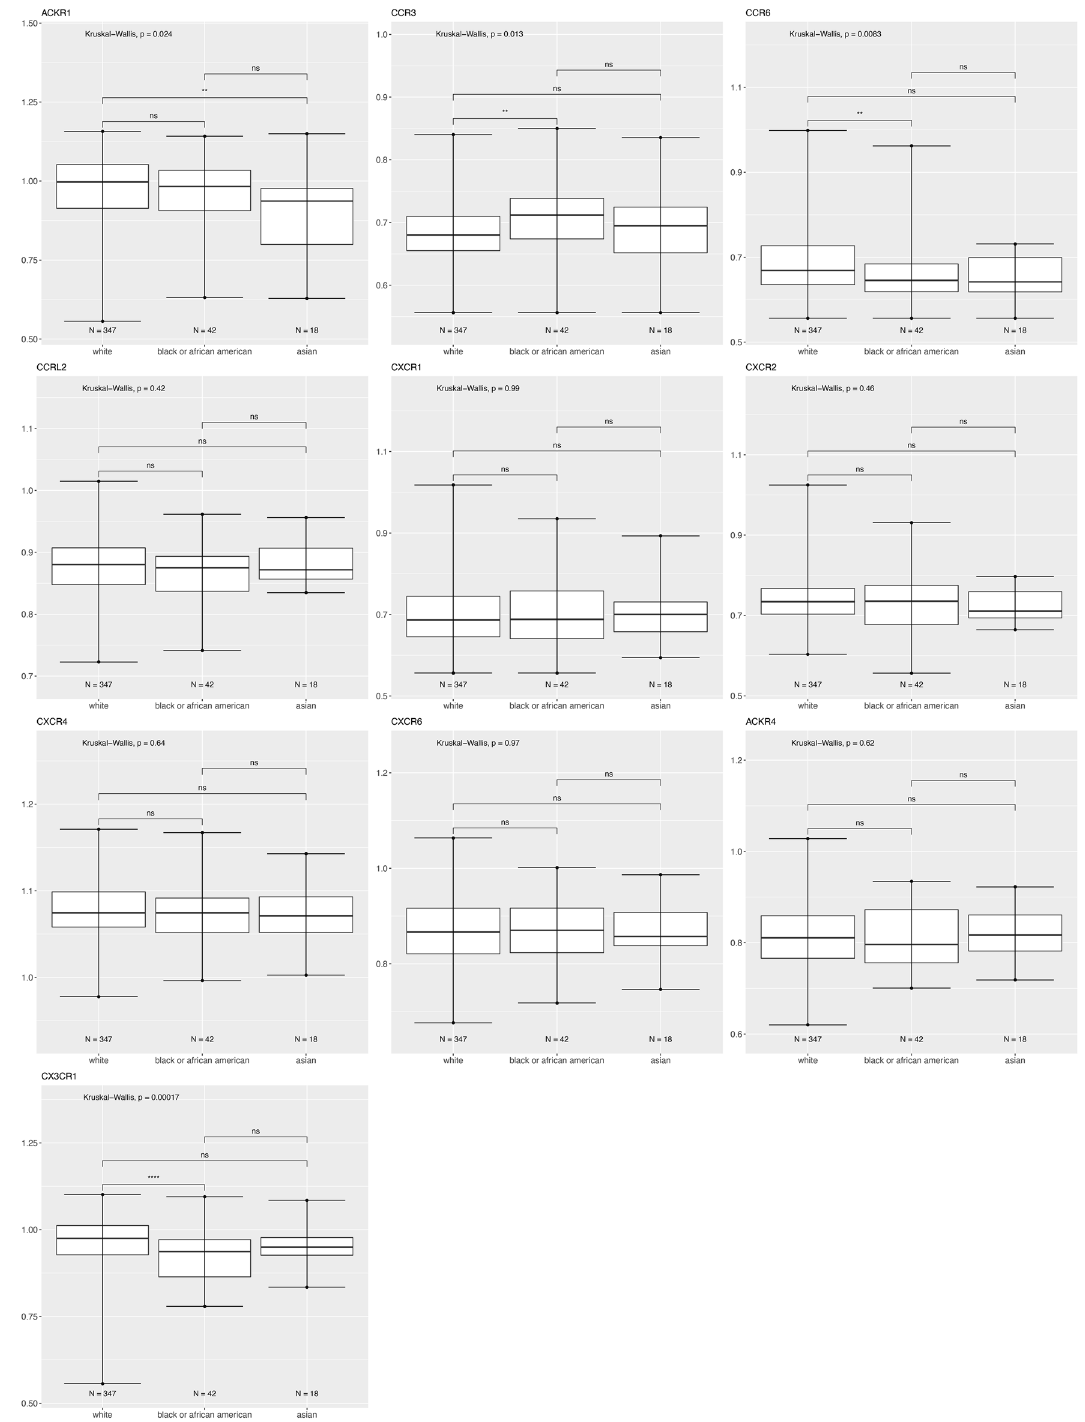
Figure 5. Differentially expressed chemokine receptor gene expression based on race within Luminal A subtype using the breast cancer TCGA data for tumor samples only. Box and whisker plots represent minimum expression at the bottom whisker, maximum at the top whisker and median at the middle line with a Log10 axis scale showing gene expression of the chemokine receptors. Statistical significance was determined with global significance for ANOVA with Kruskal